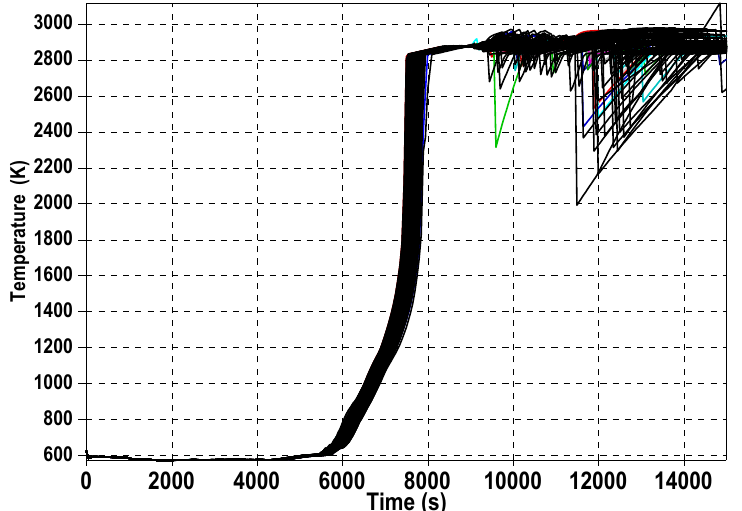
Figure 7. Maximum core temperature.